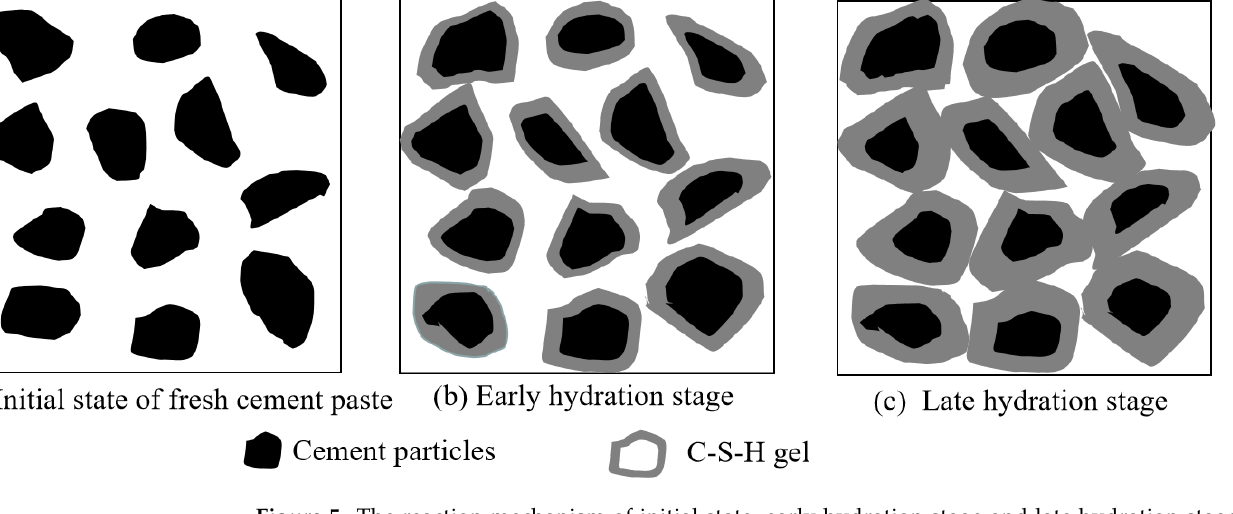
Figure 5. The reaction mechanism of initial state, early hydration stage and late hydration stage of CBM.